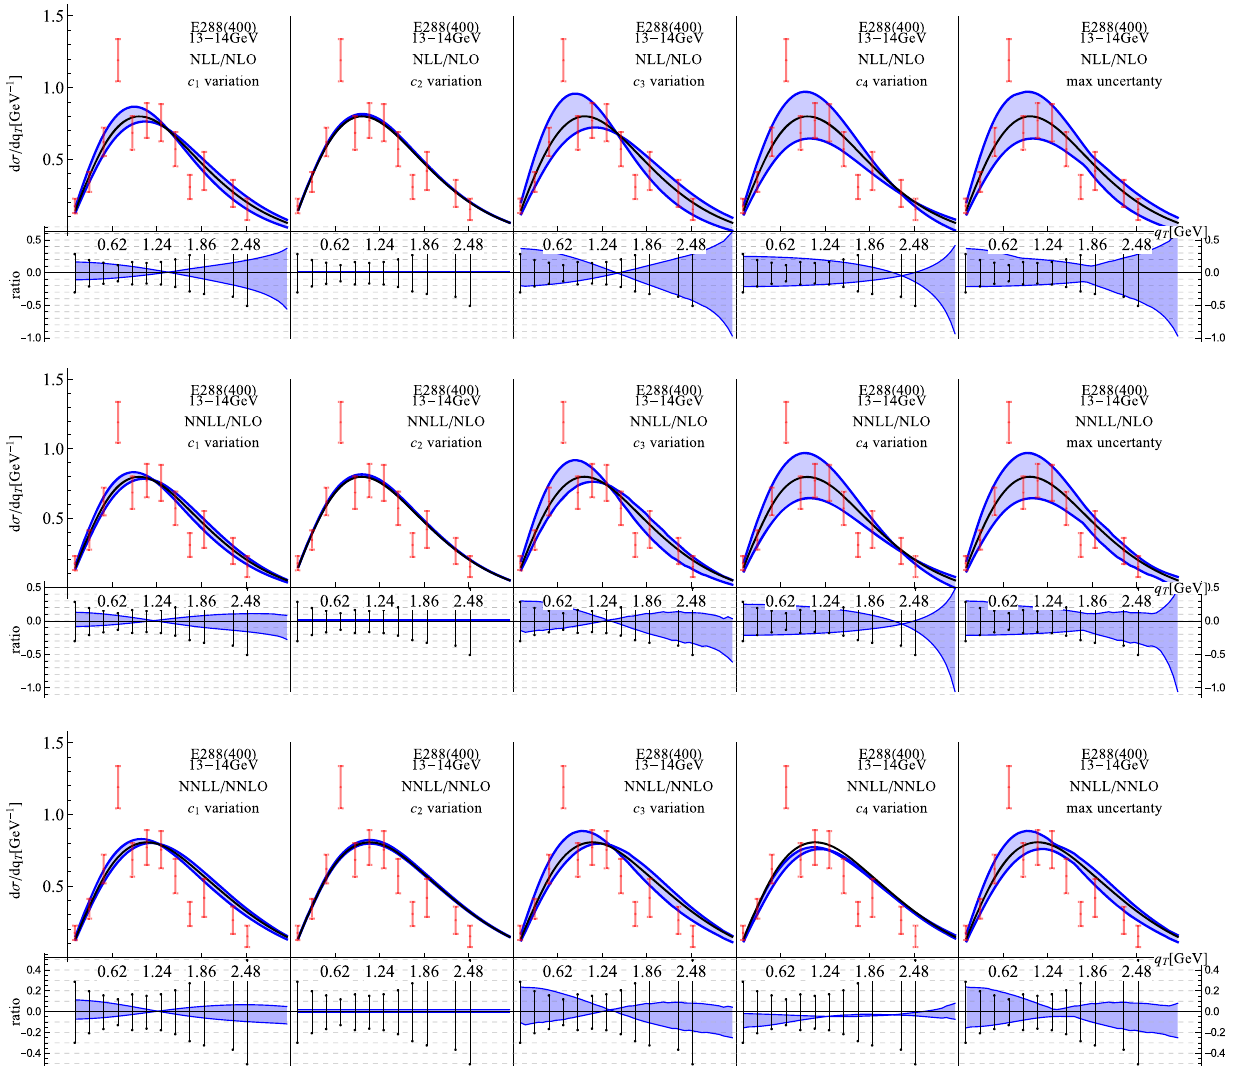
nonpertubative input is provided by model 2 . The sub-panels show the ratio of deviation to the central line (with c i =